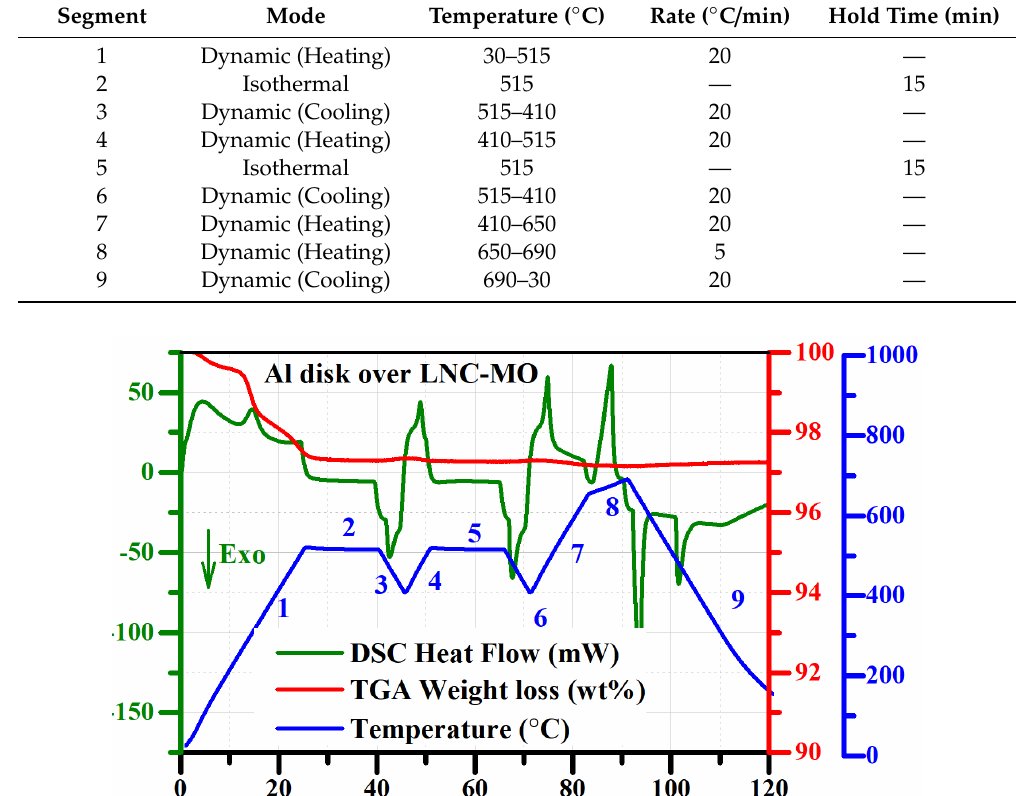
Table 2. The differential scanning calorimetry (DSC) thermal conductivity measurement program.